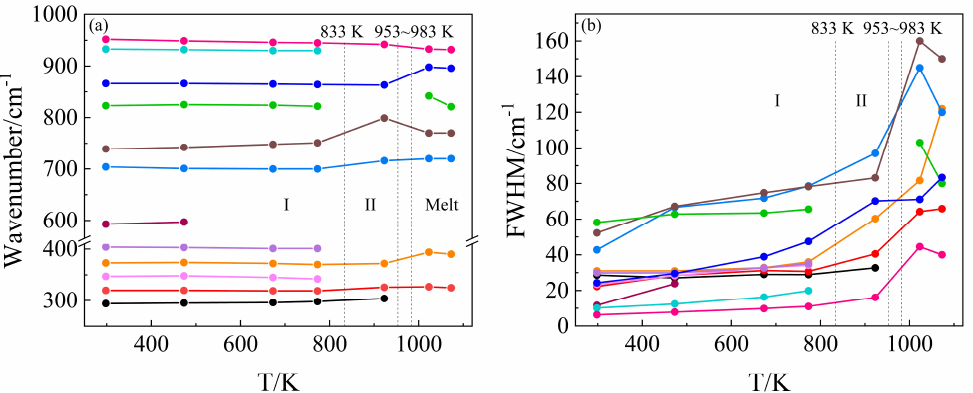
Figure 3. ( a ) Wavenumber versus temperature and ( b ) full width at half maximum (FWHM) versus temperature plot for the major stretching and bending vibrational modes of KBi(MoO 4 ) 2 . The vertical dashed lines indicate the reported temperature [27,37] at which the phase transition (phase I: monoclinic, phase II: tetragonal, and the melting point of 953–983 K) takes place.